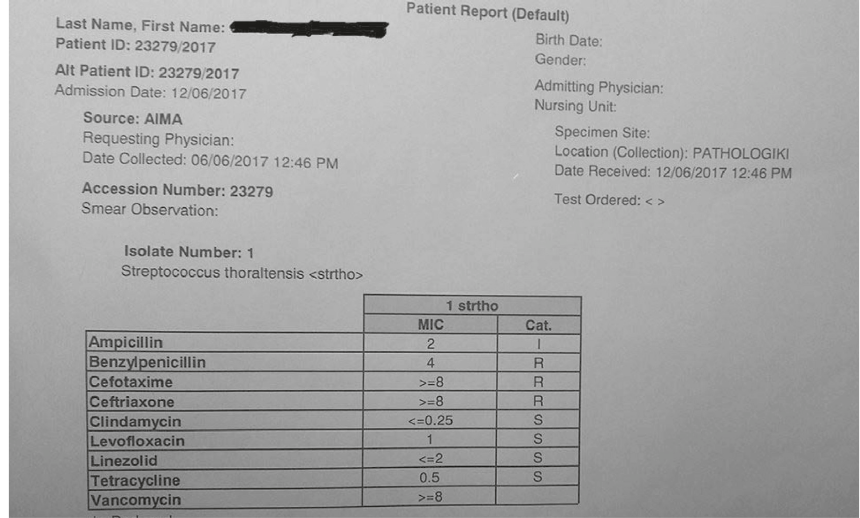
Figure 1: Susceptibility test of Streptococcus thoraltensis